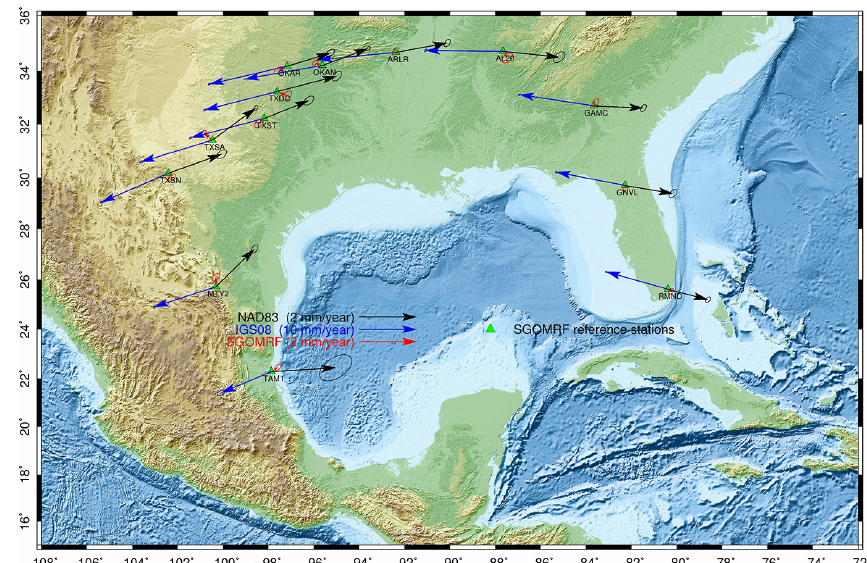
Figure 2. Map showing the locations and velocity vectors with 95% confidence ellipses of the 13 reference stations used to define SGOMRF. Black vectors are referred to NAD83; blue vectors are referred to IGS08; red vectors are referred to